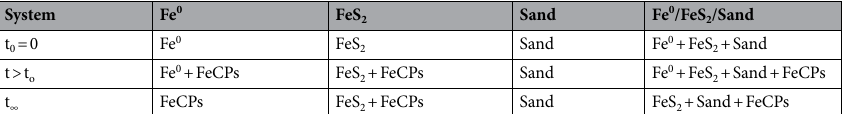
Table 3. Time-dependent inventory of reactive species in the four investigated systems. t 0 corresponds to the start of the experiment, while t ∞ corresponds to Fe 0 depletion. It is assumed that because of Fe II cycling FeS 2 will be depleted the last. FeCPs = Fe corrosion products. FeCPs can be free or coated on